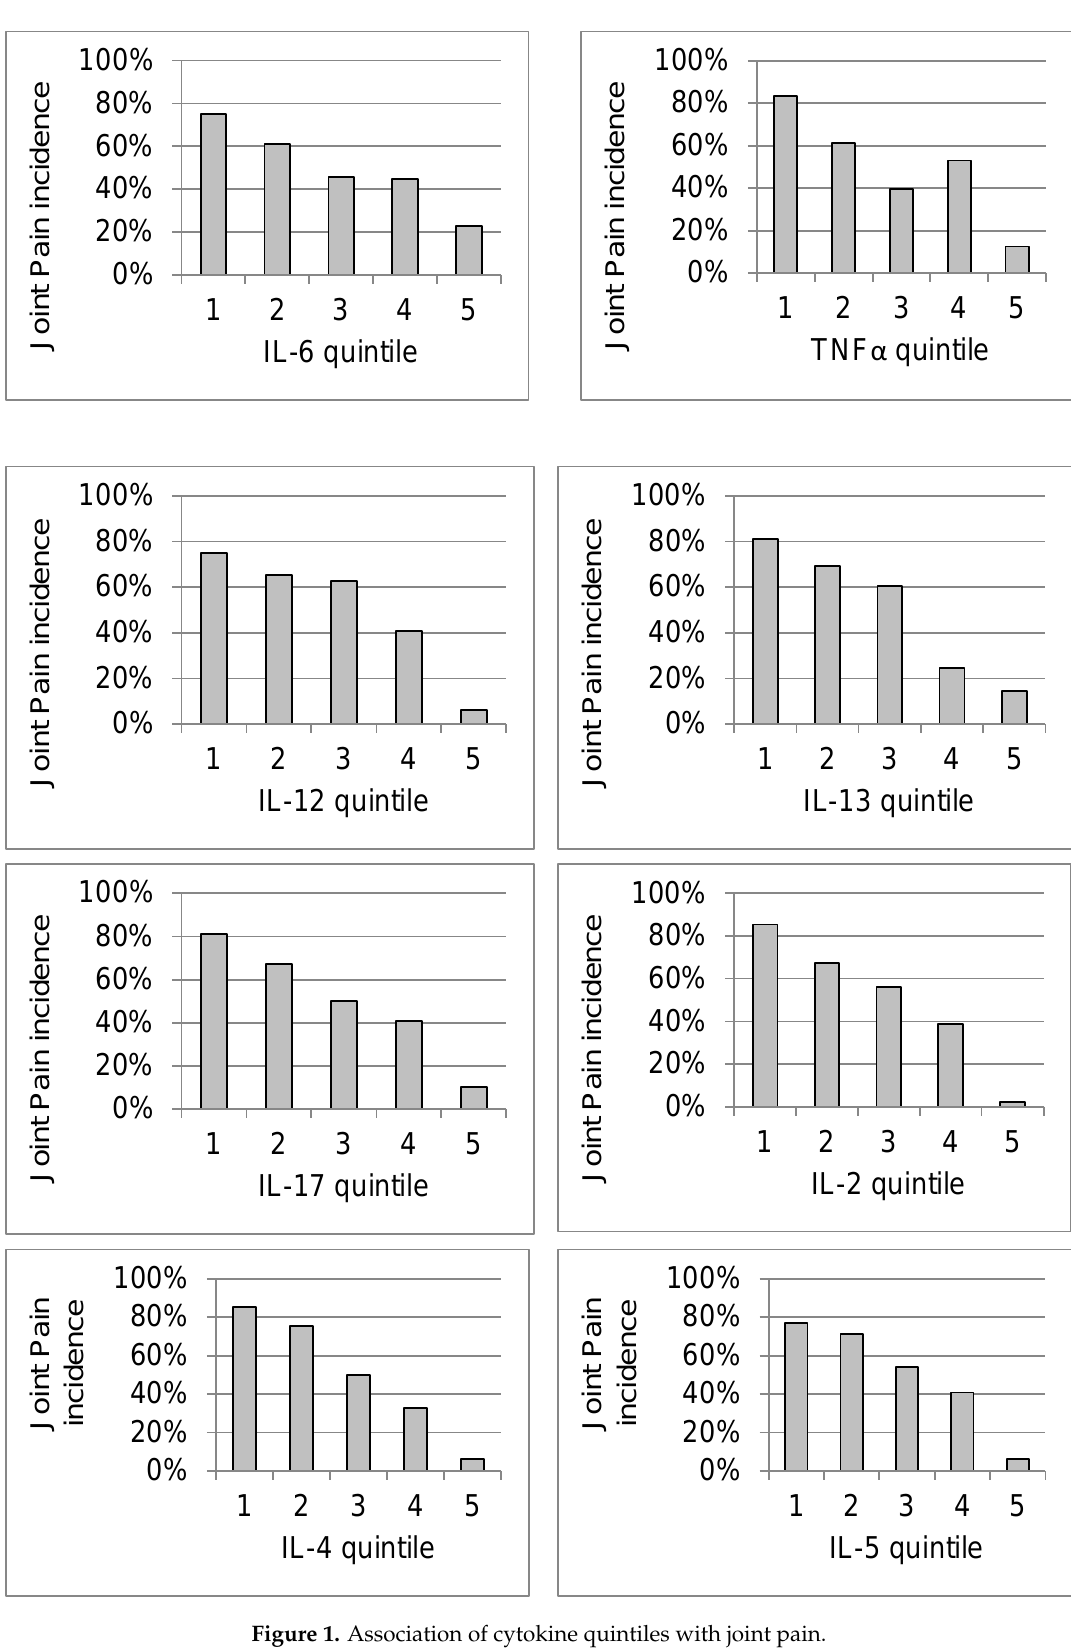
Figure 1. Association of cytokine quintiles with joint pain.